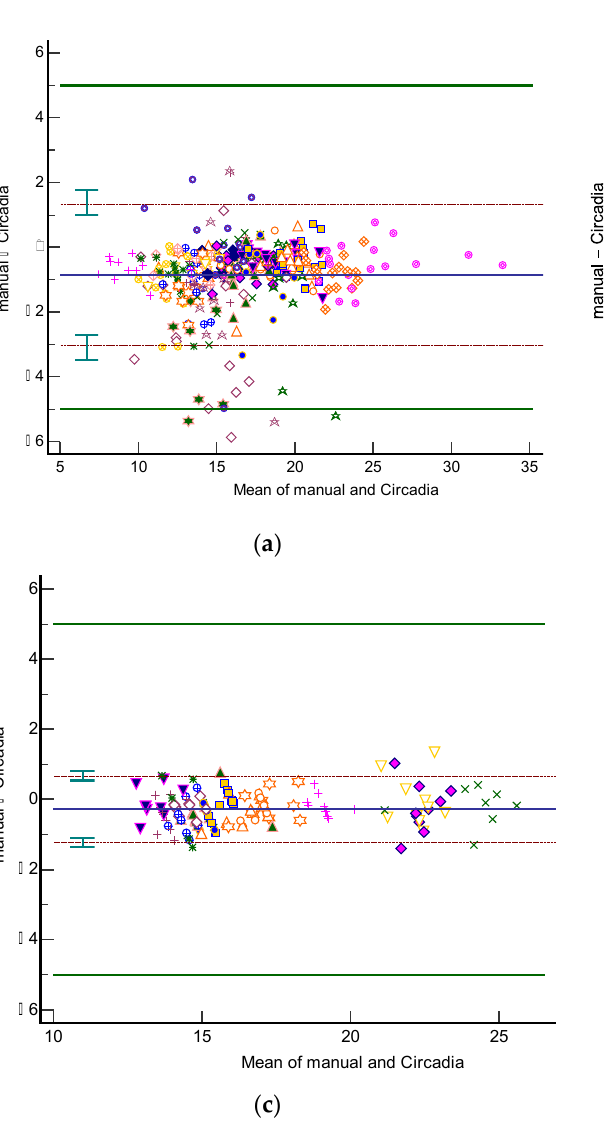
Figure 4. Bland–Altman plots of respiratory rate agreement between Circadia and reference for Study 1 ( a ), Study 2 ( b ), and Study 3 ( c ). The bias (solid blue line) and 95% limits of agreement (LOA; brown dashed lines) are indicated, as well as confidence intervals around the LOA (green error bars). Data from each subject are indicated using a unique marker. The target agreement of ±5 breaths per minute is denoted using solid green lines.